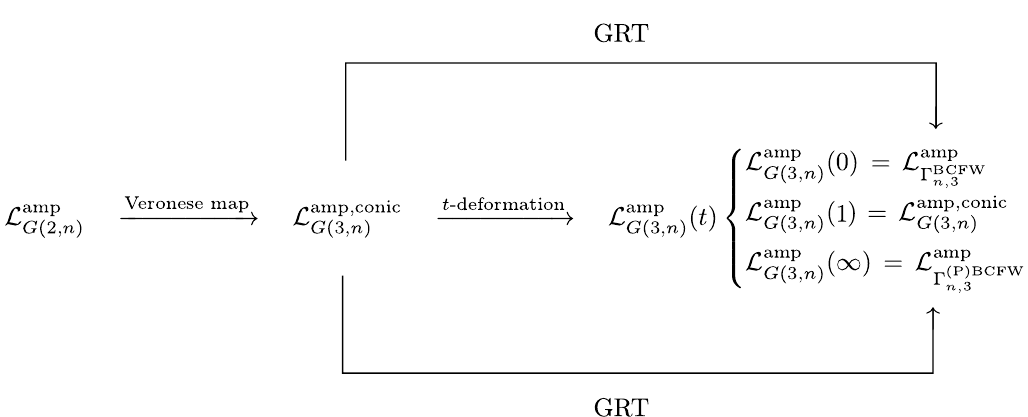
Figure 3 . Relations between di(cid:11)erent Gra(cid:25)mannian formulations of scattering amplitudes. Here L amp denotes the amplitude connected formula, which can be understood as an integral over the G (2 ;n ) Gra(cid:25)mannian G (2 ; n ). The Veronese map leads from L amp to the Gra(cid:25)mannian integral with G (2 ;n ) conic constraints, L amp ; conic . There are di(cid:11)erent ways in which the Gra(cid:25)mannian integral with G (3 ;n ) BCFW or (P)BCFW integration contour, L amp , can be obtained from this representation: either (cid:0) n; 3 via the smooth deformations of the conic constraints L amp ; conic G (3 ;n